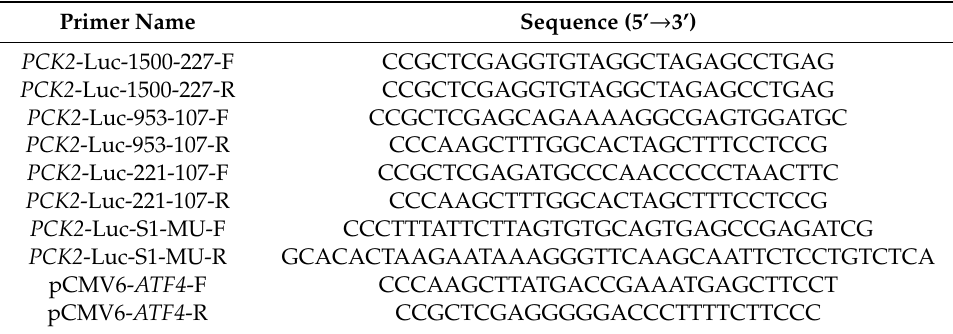
Table 4. Primers for the recombinant